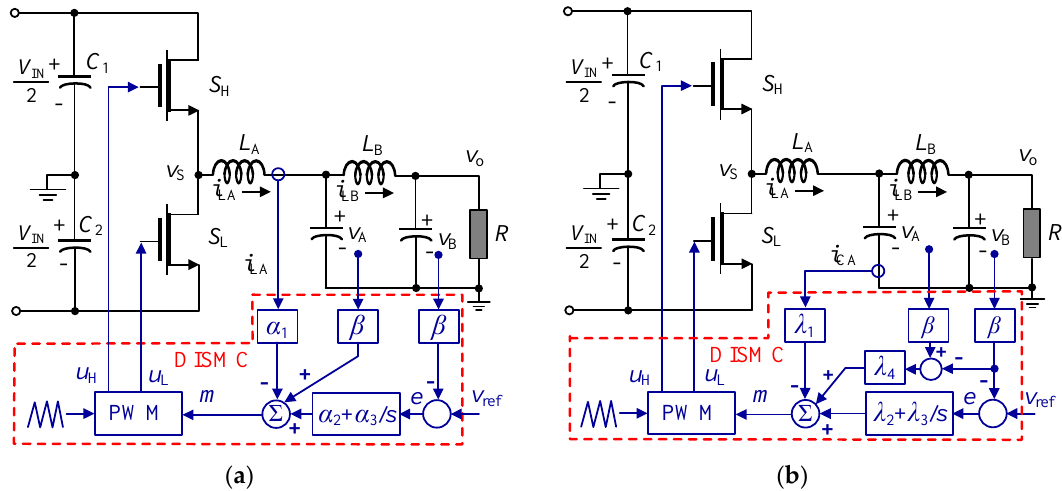
Figure 3. FFDISM controller of fourth-order class-D amplifier using ( a ) i LA feedback (CNRL1) ( b ) i CA feedback (CNRL2).